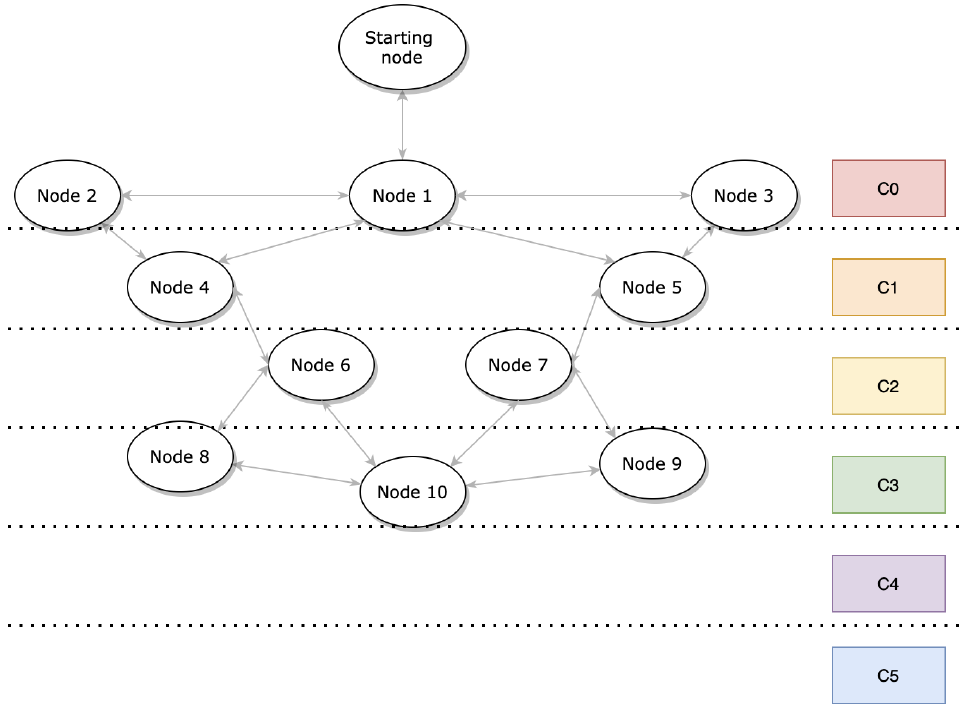
Figure 4. Second network topology used in the performance